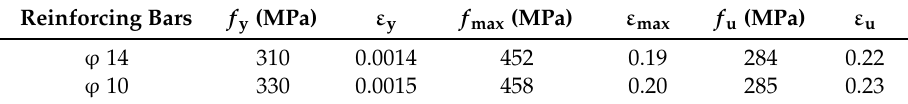
Table 1. Mechanical properties of longitudinal and transverse reinforcement.